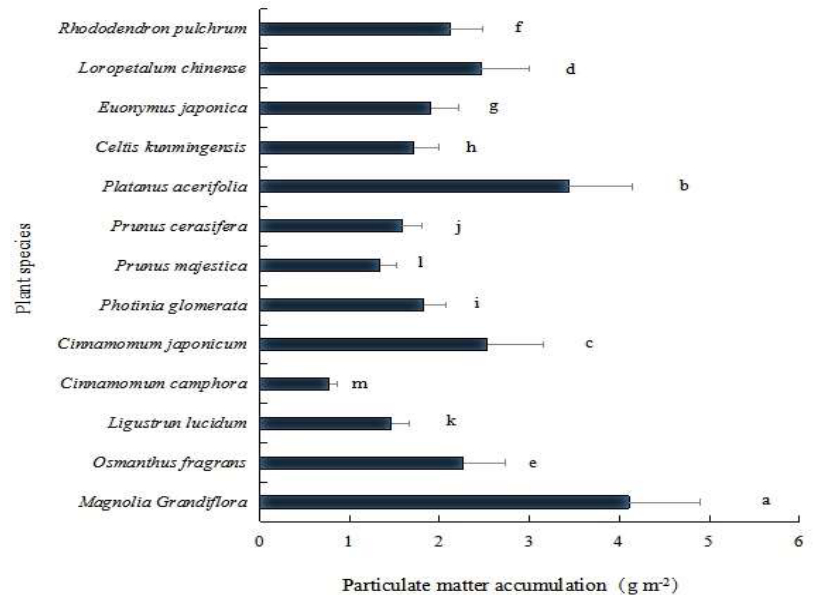
Figure 3. Accumulation of total particulate matter (PM) on the leaf surfaces of tree and shrub species in Kunming City, China. Bars are mean ± SE (standard error). Treatments with the same letter were not significantly different (ANOVA with Duncan test, p < 0.05).